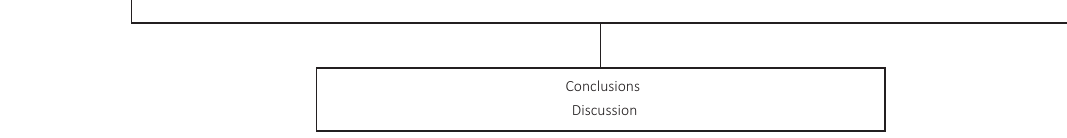
=total length (m) of edge in landscape between patch types (classes) i and k; includes the entire landscape boundary and some or all background edge segments involving class i. =total landscape area ( ㎡ ).